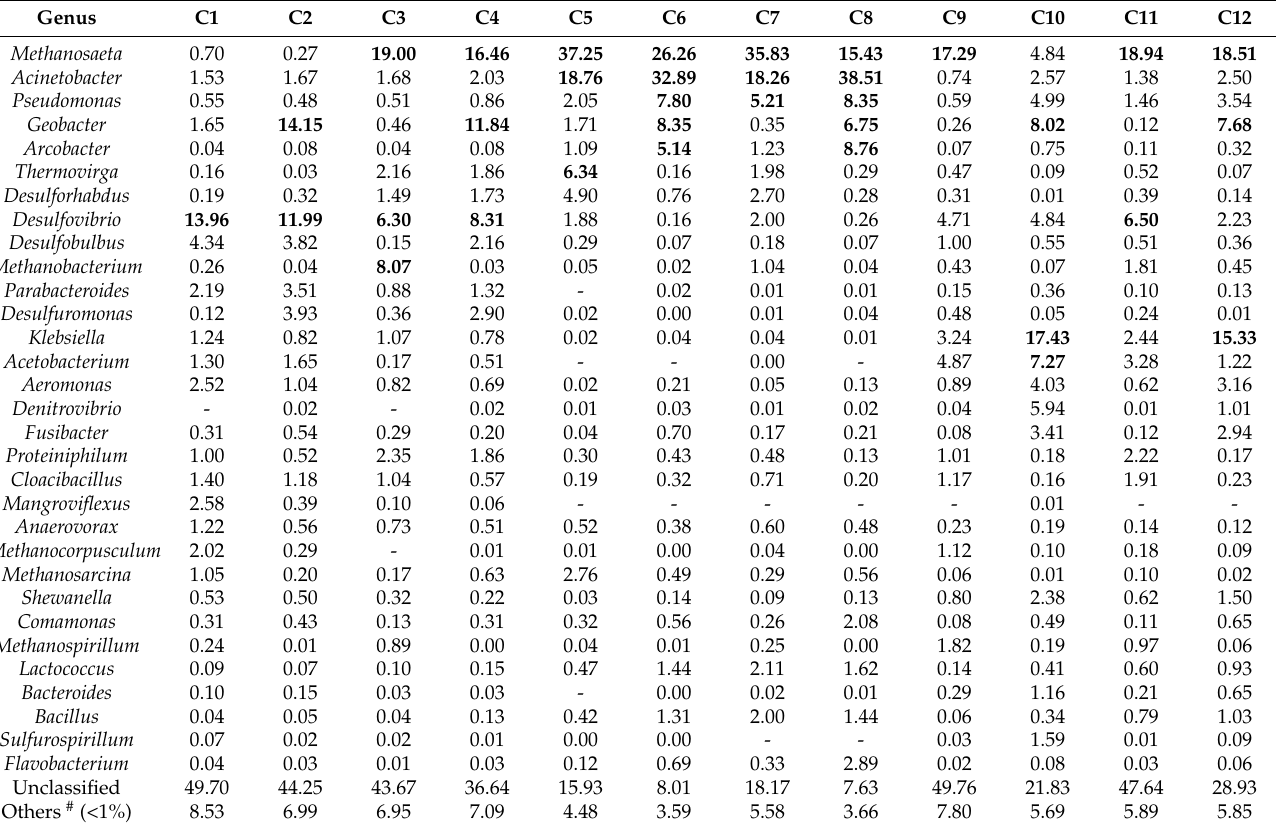
Table 2. Microbial community comparison at genus